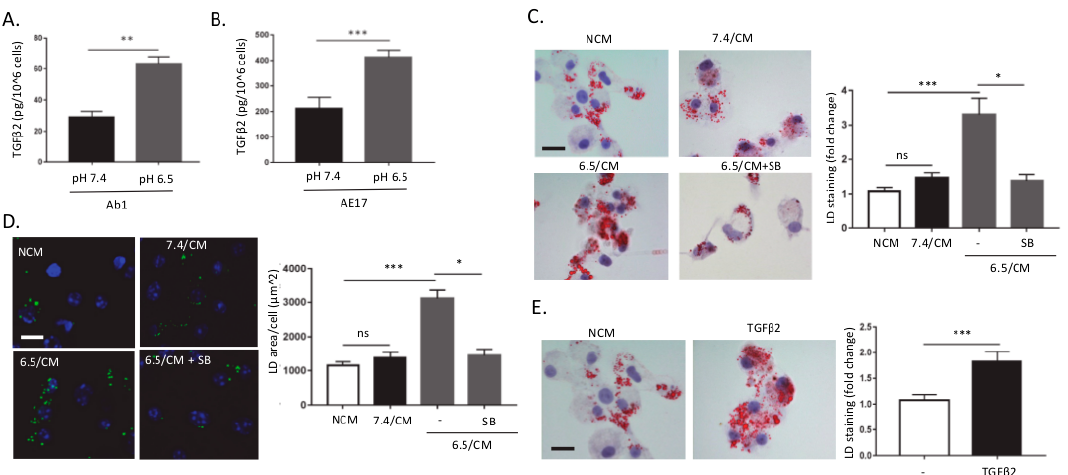
Figure 1. TGF- β 2-dependent lipid droplet accumulation in dendritic cells in response to the acidic mesothelioma milieu. ( A , B ) Control (pH 7.4) and acidosis (pH 6.5)-adapted Ab1 ( A ) and AE17 ( B ) mesothelioma cells were grown for 48 h, and active TGF- β 2 secretion was assayed using ELISA. ( C – E ) Dendritic cells (DCs) were incubated with non-conditioned medium (NCM) or treated for two days either with conditioned medium (CM) from mesothelioma cells maintained at pH 7.4 or pH 6.5 (7.4 / CM and 6.5 / CM, respectively) ( C , D ) or with 4 ng / mL recombinant TGF- β 2 ( E ). In some experiments, DCs were also exposed to 5 µ M SB-431542. Representative pictures of lipid droplet (LD) content as determined using Oil Red O (ORO) (scale = 20 µ m) ( C , E ) or BODIPY 495 / 503 staining (scale: 20 µ m, green: BODIPY 495 / 503, blue: DAPI) ( D ) are shown together with quantification of the cellular area covered by LDs ( n = 3, * p < 0.05, ** p < 0.01, *** p < 0.001; ns = non-significant).